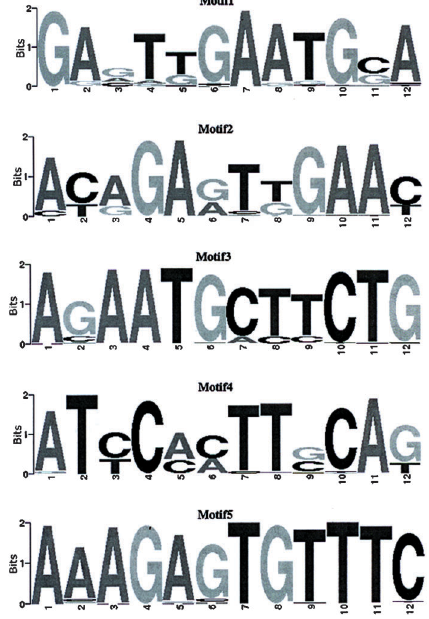
Figure 4. ChIP-seq motif logo. The lateral axis indicates locus of motif. The total height of the vertical axis reflects the conservation of the motif. The height of each base represents probability of the